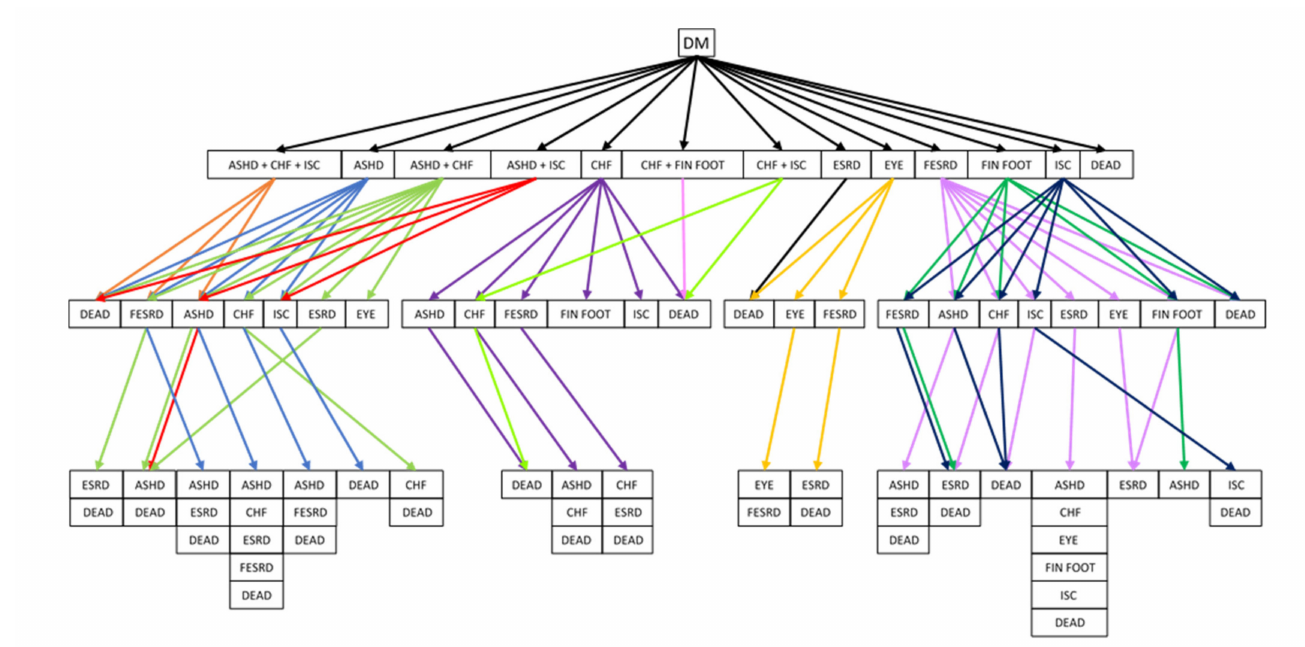
Figure 2. A tree structure of diabetes mellitus complications. Abbreviation: DM, diabetes mellitus; ASHD, arteriosclerotic heart disease; CHF, chronic heart failure; EYE, retinopathy; FESRD, first-time renal failure; FIN_FOOT, amputation; ISC, ischemic